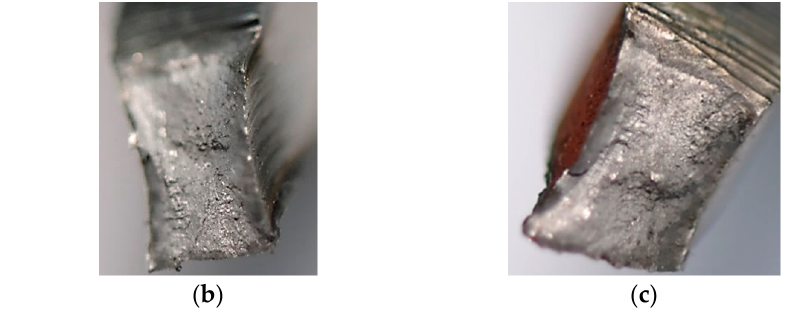
Figure 8. Fracture zone of the Hardox 450 welded in MAG process after the tensile test: ( a ) general view, and ( b , c ) both parts of the region.